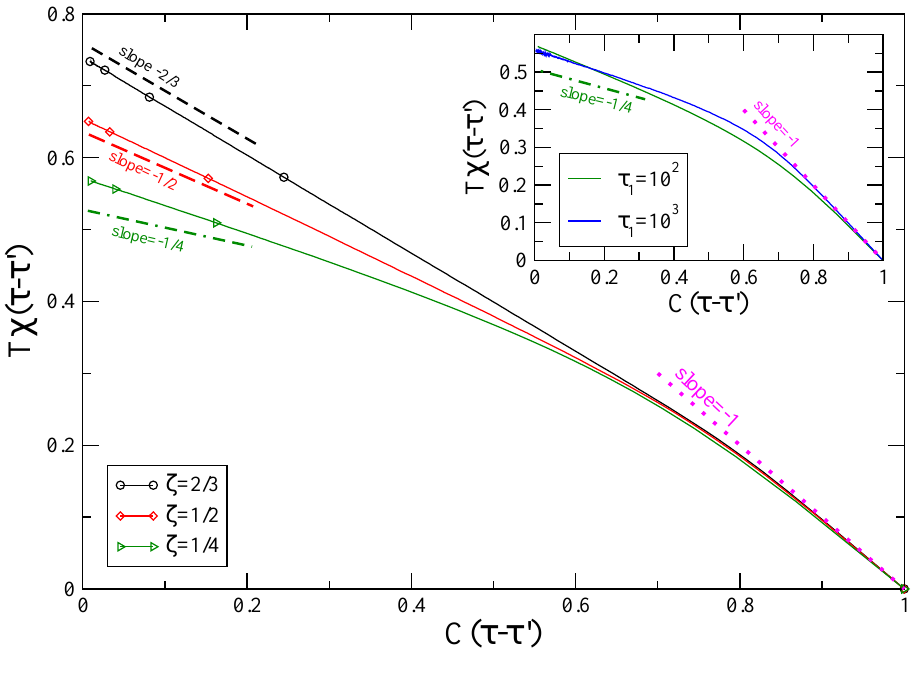
Figure 2: The fluctuation-dissipation plot of the model with multithermalized cou- pling constants J . The integrated response T χ ( τ , τ (cid:48) ) is plotted against the auto- ij correlation function C ( τ , τ (cid:48) ) for a system of N = 2 10 spins with random bimodal (cid:112) = ± 1 / N . The temperature of the spins is T = 1 / 2 and that coupling constants J ij of the J s is T (cid:48) = T /ζ , with the three values ζ = 2 / 3, 1 / 2, and 1 / 4. All the curves are ij computed on a stationary system, which is obtained by letting τ (cid:48) = 50 for ζ = 2 / 3 and ζ = 1 / 2, and τ (cid:48) = 25 for ζ = 1 / 4. Data are averaged over 5 · 10 4 − 10 6 real- isations, for the various cases. The perturbation applied for the computation of the = 10 2 for all the response function is H = 0.1. The timescale of the slow bath is τ 1 = 10 3 ). The dotted line is the curves (except the blue one in the inset, for which τ 1 equilibrium slope − 1 while the dashed ones are the expected slopes in the small C sector. In the inset a comparison is presented for ζ = 1 / 4 between the system with τ = 10 2 and τ = 10 3 1 1